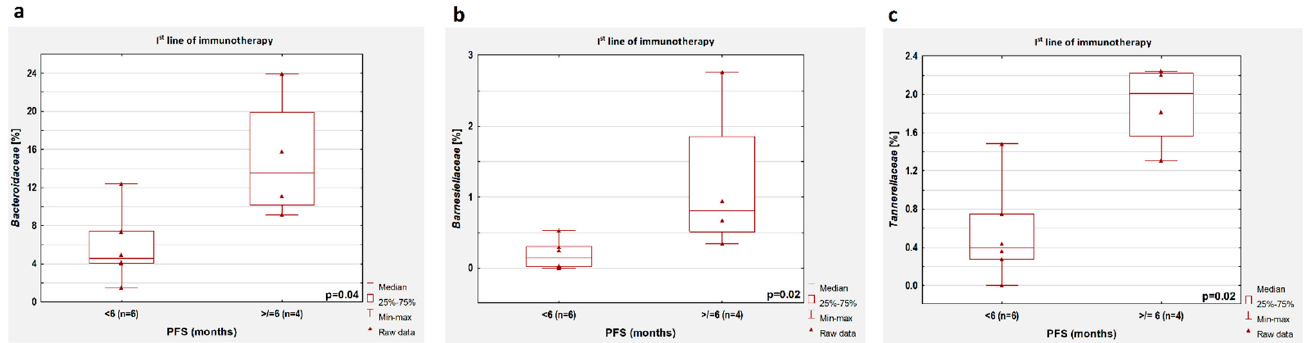
Figure 5. Boxplot showing Verrucomicrobiota content in patients with different responses to immunotherapy.